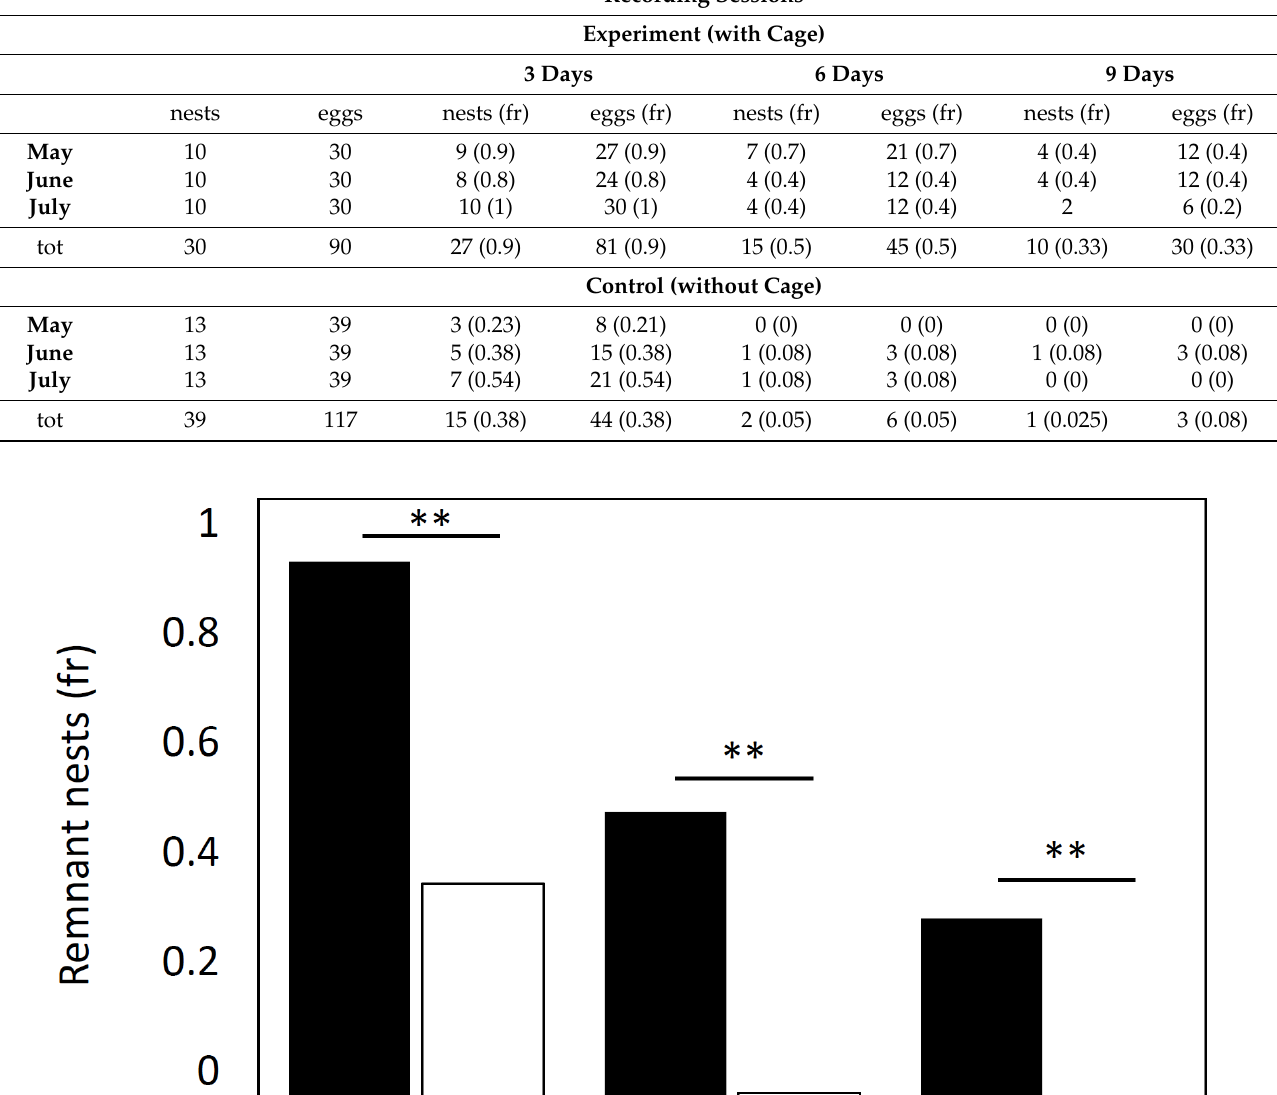
Table 1. Number and relative frequency (fr) of remnant nests and eggs in experiments (with cage) and controls (without cage) during the recording sessions (three, six, and nine days) in the three sub-seasonal sessions (May, June, and July).